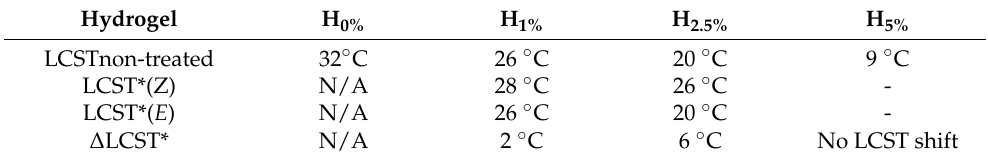
Table 2. Thermodynamic characteristics of Control-PNIPAAm and Azo-PNIPAAm hydrogels.